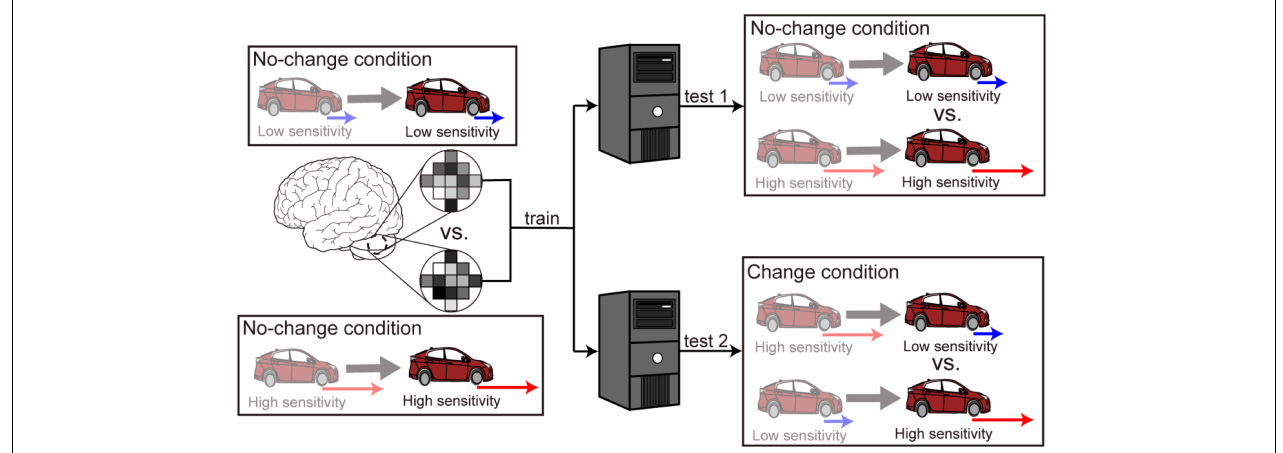
FIGURE 2 | Multivoxel pattern analysis procedure. First, a classifier was trained to discriminate high from low sensitivity using the fMRI data in the no-change conditions. The trained classifier was applied separately to the data in the no-change conditions (denoted as “test 1”) and the data in the change conditions (denoted as “test 2”). The anterior and posterior parts of the cerebellum split into the left and right sides are selected as